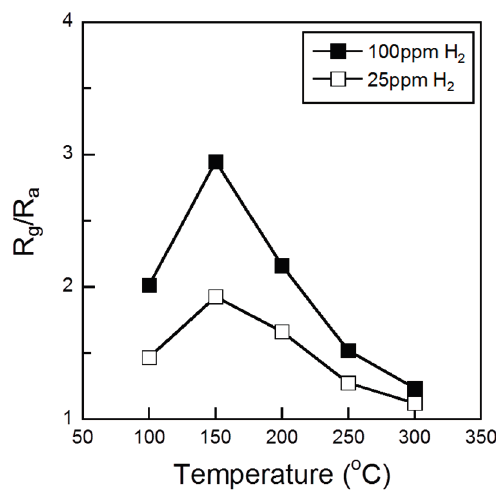
Figure 8. Sensing responses of the sensor element using 10%Pd/Co 3 O 4 powder to 25 and 100 ppm H 2 as a function of the operating